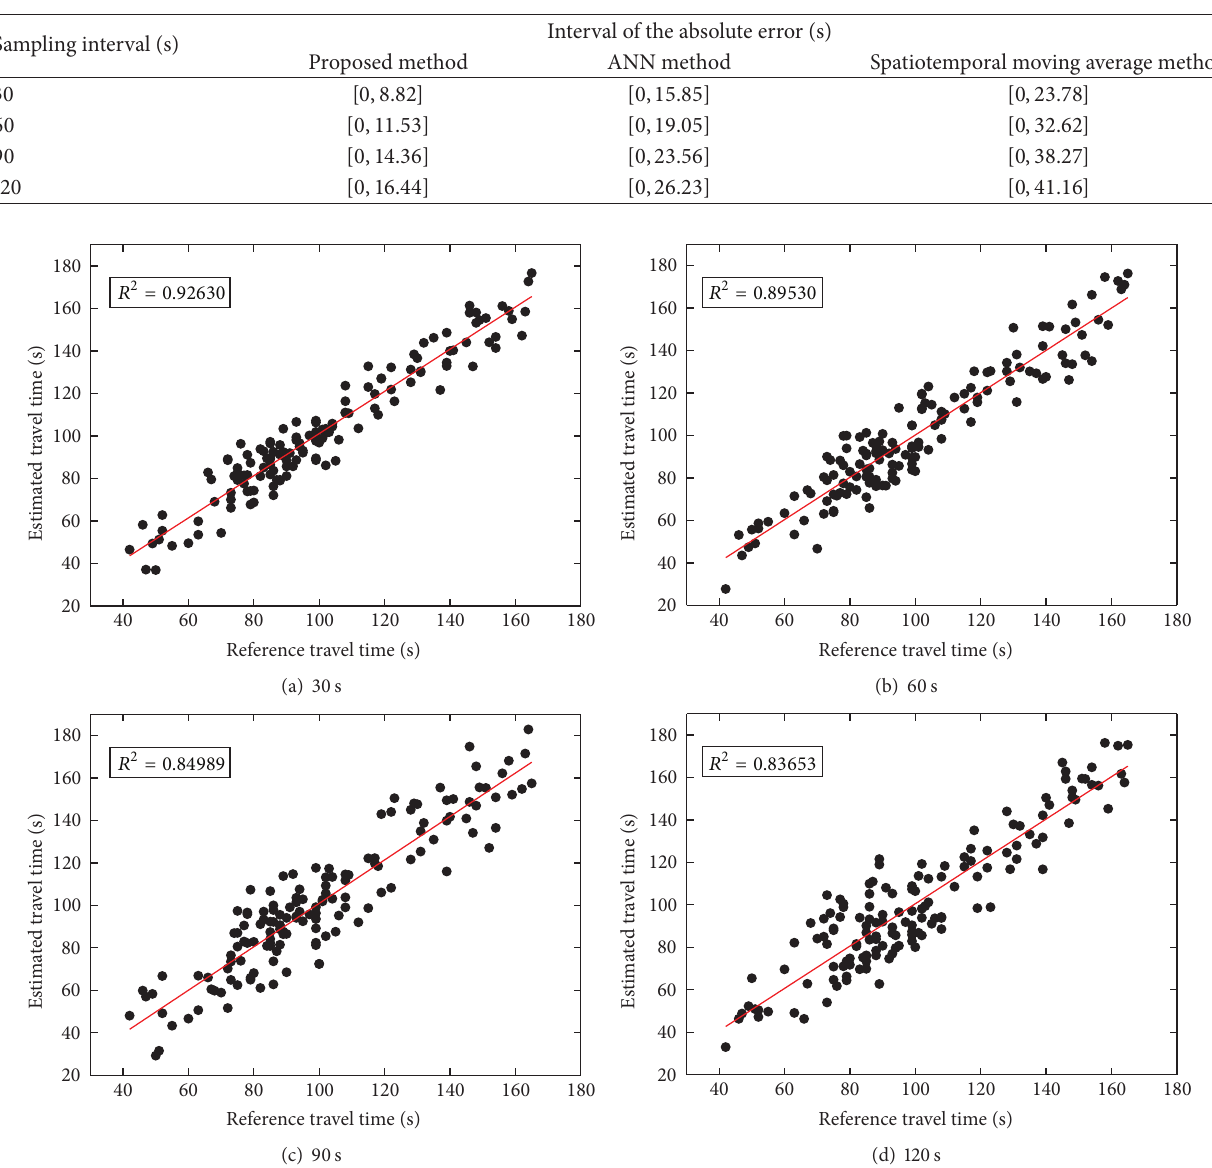
Table 4: 95% credible interval of the absolute error based on the three estimation methods.